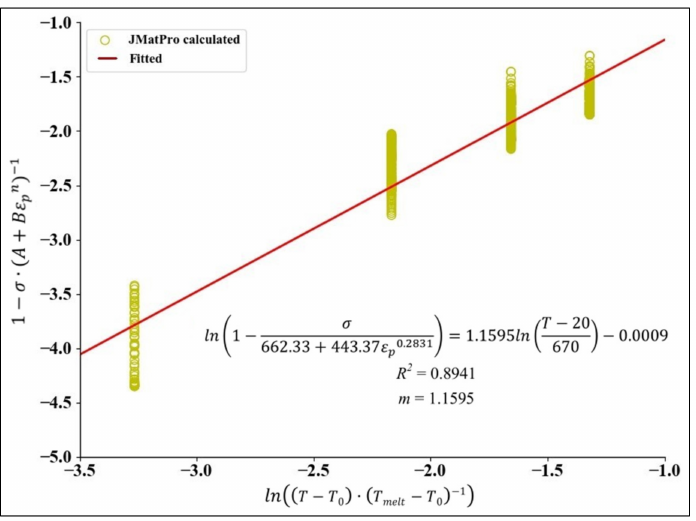
Figure 8. Solution of parameter m .